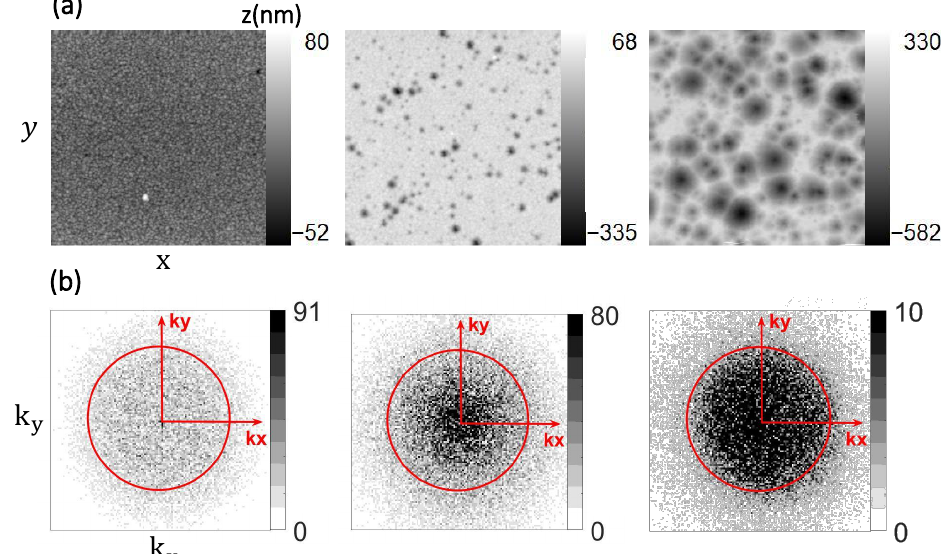
Figure 2. ( a ) Height function z ( x , y ) extracted from 10 µ m × 10 µ m atomic force microscopy (AFM) images of rough Ag surfaces (Ref. [28]) with varying root mean square (rms) roughnesses of 8.86, 30.48, and 134.17 nm from left to right, respectively, and ( b ) the corresponding absolute values of their 2D Fourier components for the reflected scalar field (Equation (3) at 650 nm of wavelength). n 2 The red circle indicates the condition k 2 x + k 2 y = k 2 . Absolute values were scaled by a factor of 5 for 0 1 better contrast, and images were resized to 128 × 128 pixels for